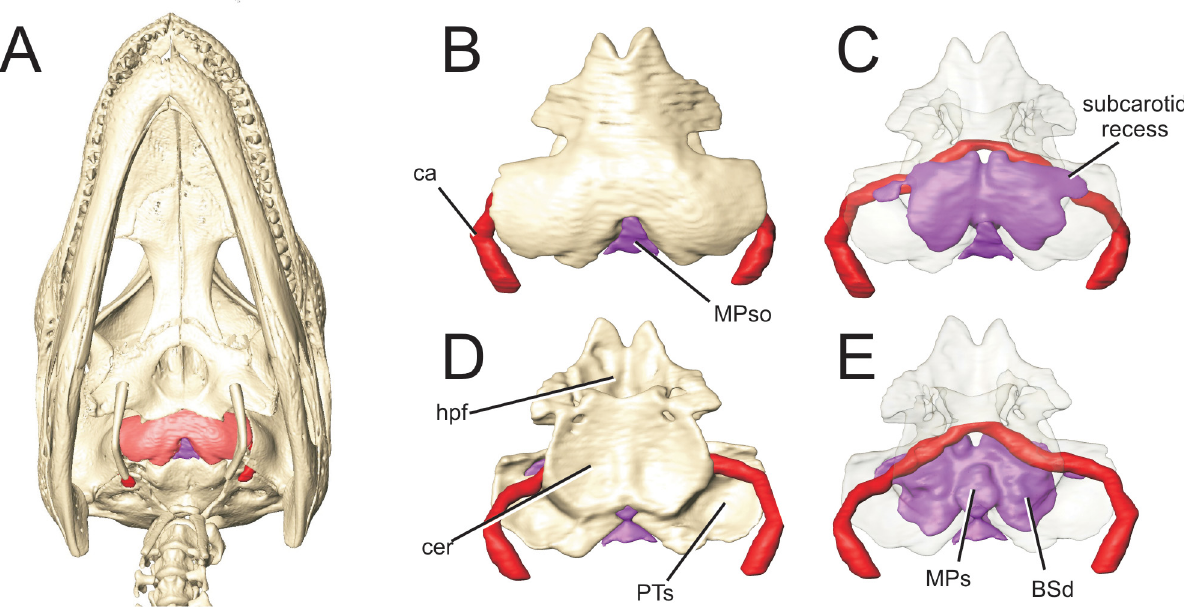
Fig 5. Perinatal Alligator mississippiensis (OUVC 10606) demonstrating the median pharyngeal sinus system. Rendered in A) ventral aspect with the basisphenoid in red. Isolated basisphenoid shown in B) ventral aspect and C) rendered transparent with the basisphenoidal diverticulum rendered in purple. Basisphenoid shown in D) dorsal aspect and E) rendered transparent. BSd , basisphenoid diverticulum; ca , carotid artery; cer , cerebral fossa; hpf, hypophyseal fossa; MPs , median pharyngeal sinus; MPso , ostium for median pharyngeal sinus; PTs , pharyngotympanic sinus.